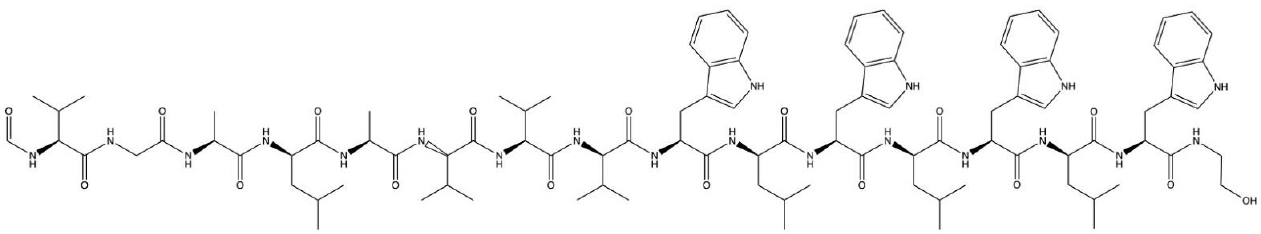
Figure 1. Chemical structure of antimicrobial peptide gramicidin A. Gramicidin A is a linear antimicrobial peptide and one of the three known gramicidins (A, B, and C). They are non-ribosomal peptides that consist of the following 15 L- and D-amino acids: formyl-L-X-Gly-L-Ala-D-Leu-L-Ala-D-Val-L-Val-D-Val-L-Trp-D-Leu-L-Y-D-Leu-L-Trp-D-Leu-L-Trp-ethanolamine. The difference between gramicidins A, B, and C is that the amino acid position Y is L-tryptophan in gramicidin A, L-phenylalanine in B, and L-tyrosine in C. The isoforms of the gramicidins A, B, and C are determined by the existence of L-valine or L-isoleucine at position X of anion acid and the origin